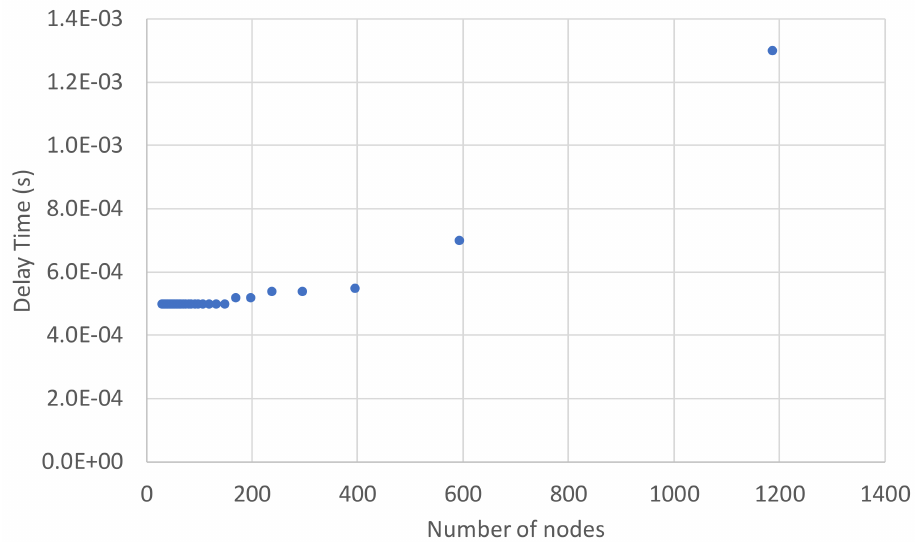
Figure 6. The delay time in computing user-object distances in the case of no graphical output as a function of the number of nodes used to describe the objects in the